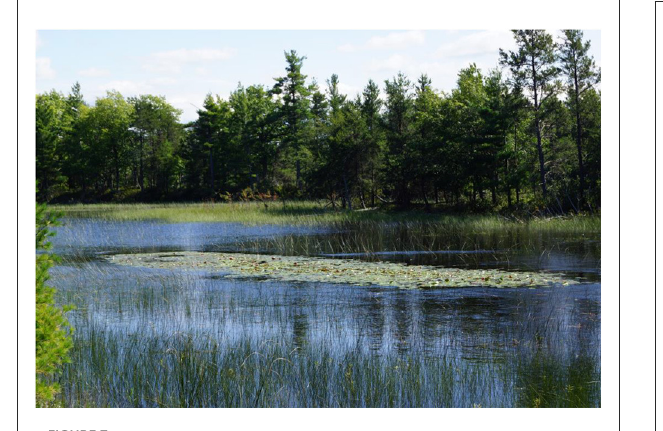
FIGURE7 Swale in SLBE.